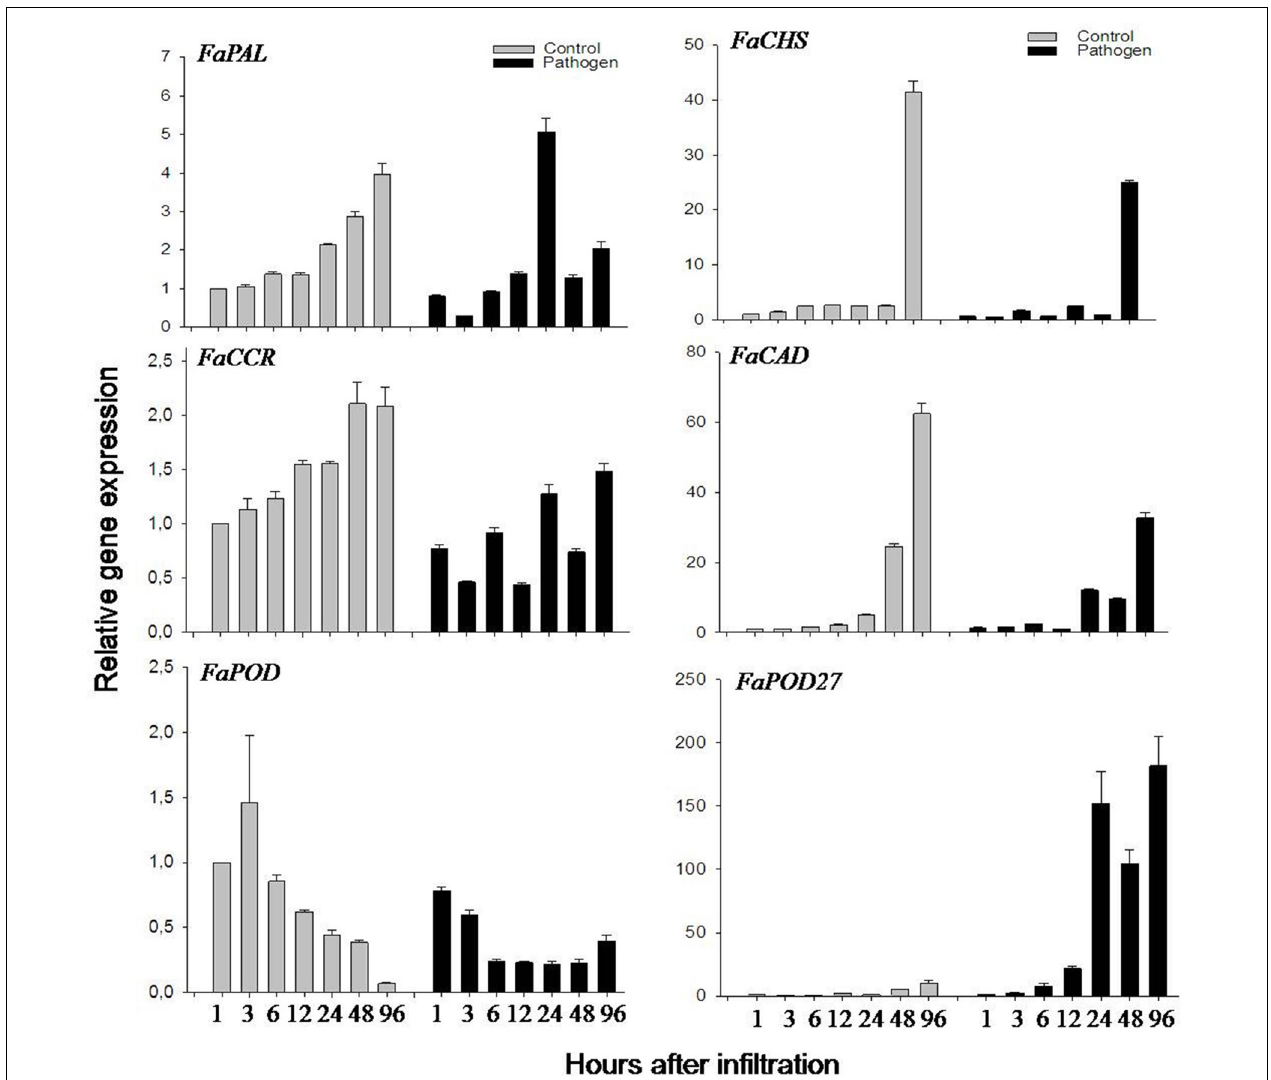
FIGURE 3 | Relative expression profiles of phenylpropanoid biosynthesis genes of F . × ananassa cv. Elsanta in response to Agrobacterium . Expression levels in control (gray column) and agroinfiltrated fruits (black column) were monitored by qRT-PCR at different time points (1, 3, 6, 12, 24,